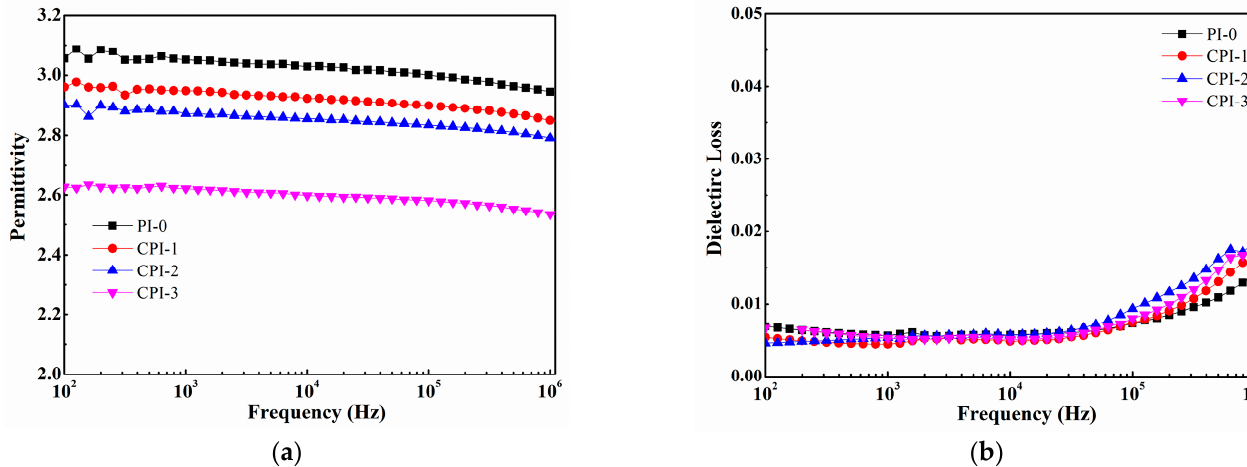
Figure 4. ( a ) Permittivity and ( b ) dielectric loss of the CPI films.